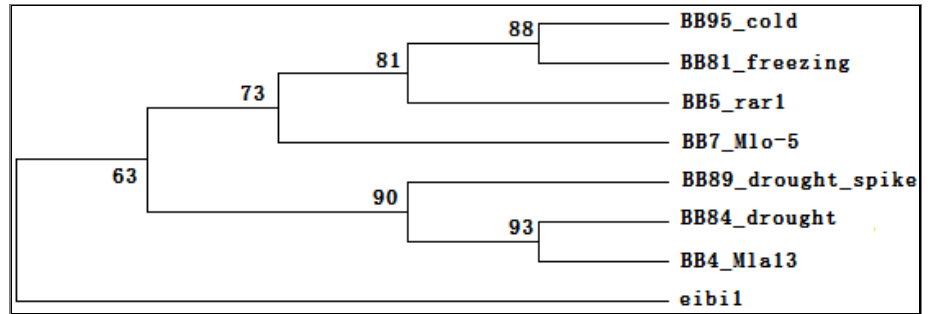
Figure 2. Hierarchical cluster analysis of differentially expressed genes from eibi1 and barley cultivars transcriptome change under various stress treatments (from data available at PlexDB